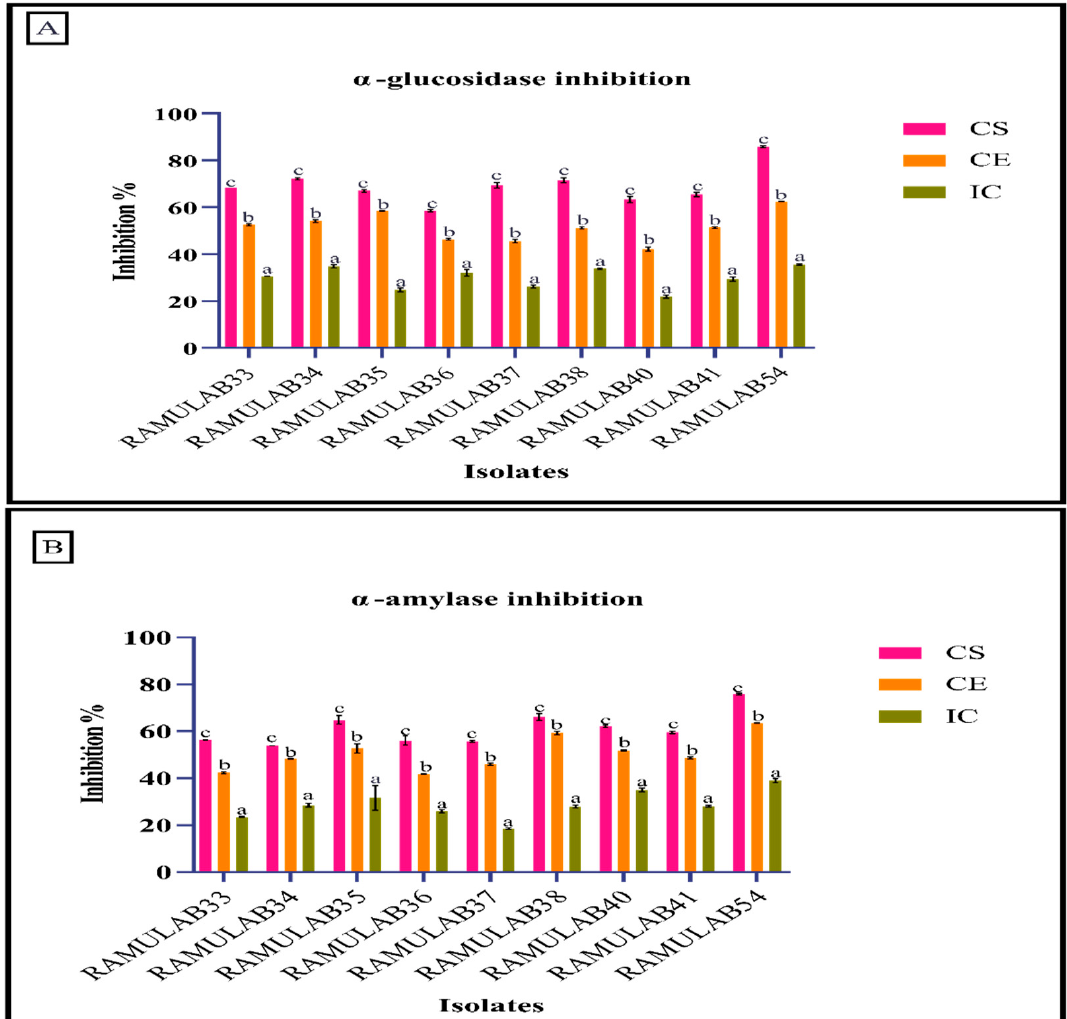
Figure 7. Shows the isolates’ ability to hinder the enzymes α -glucosidase ( A ) and α -amylase ( B ). The mean and SD are used to express data. The means of the inhibitory activity of the CS, CE, and IC with the various superscripts (a–c) are substantially different ( p ≤ 0.05), according to the Duncan multiple range test.